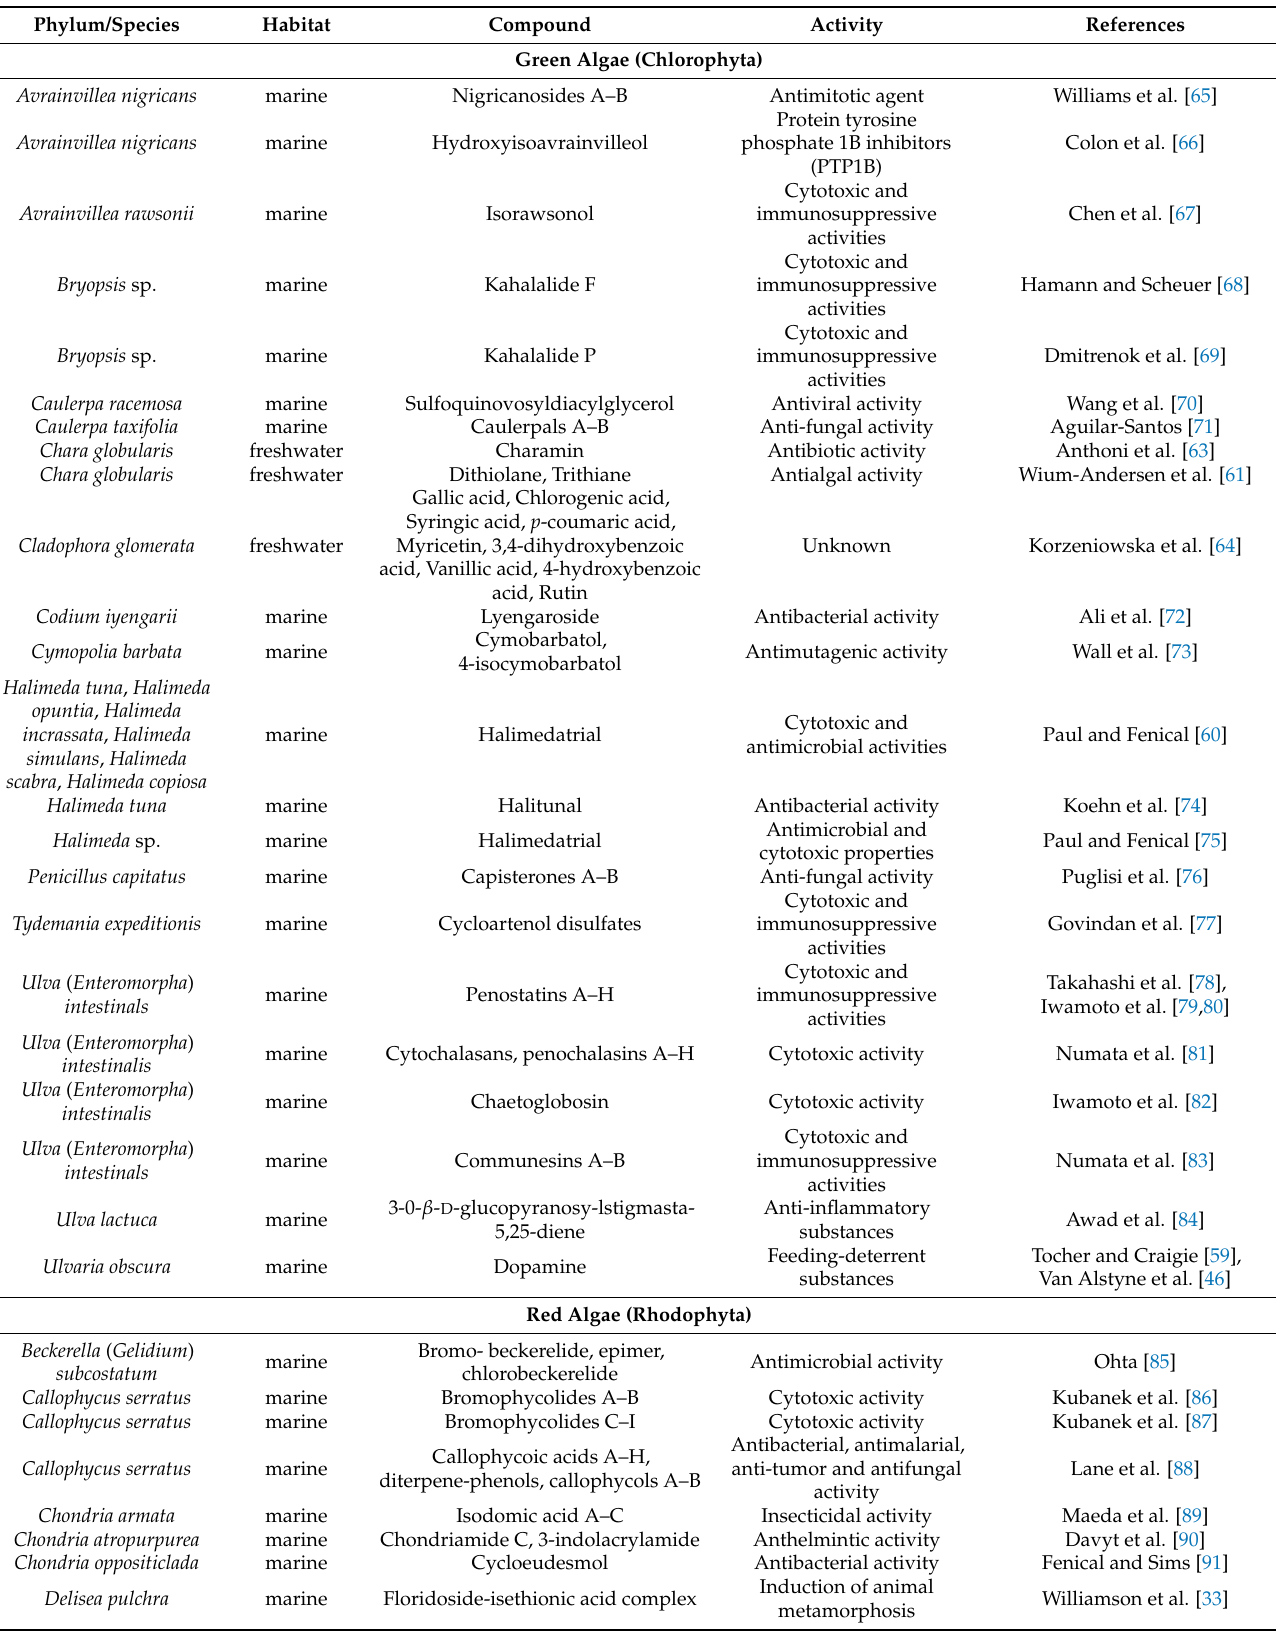
Table 4. Macroalgae capable of producing bioactive compounds against other heterotrophic organisms (not only competing and herbivorous), location of their environmental occurrence, name of compounds, and their effect on target